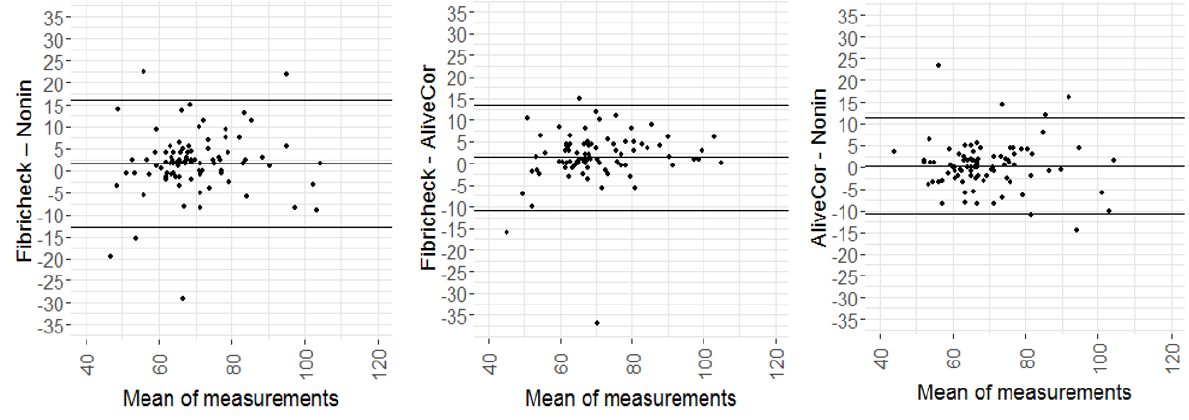
Table 4. Characteristics of patients in study 2.